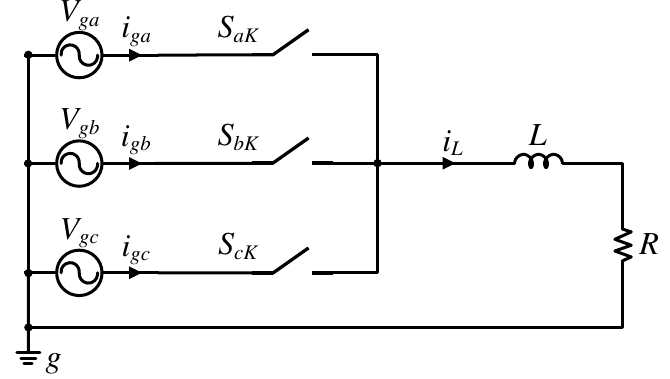
Figure 3. Basic commutation circuit of a switching cell with an RL load. Each switching state of the matrix converter specifies one output voltage and one input current space vector. These vectors can be called voltage (current) Switching Space Vectors (SSV) [38]. Therefore, the MCs synthesize the output voltage (input current) vector from the input voltages (output currents). According to the characteristics of the SSVs associated with each switching state, the 27 allowed switching states are clustered into three groups as shown in Figure